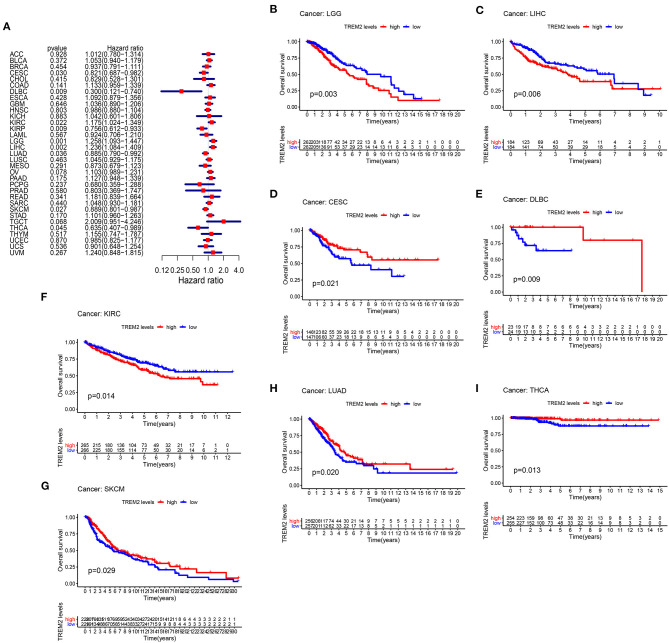
Association between TREM2 expression and overall survival time in days (OS). (A) Forest plot of OS associations in 33 types of tumor. (B–I) Kaplan-Meier analysis of the association between TREM2 expression and OS.